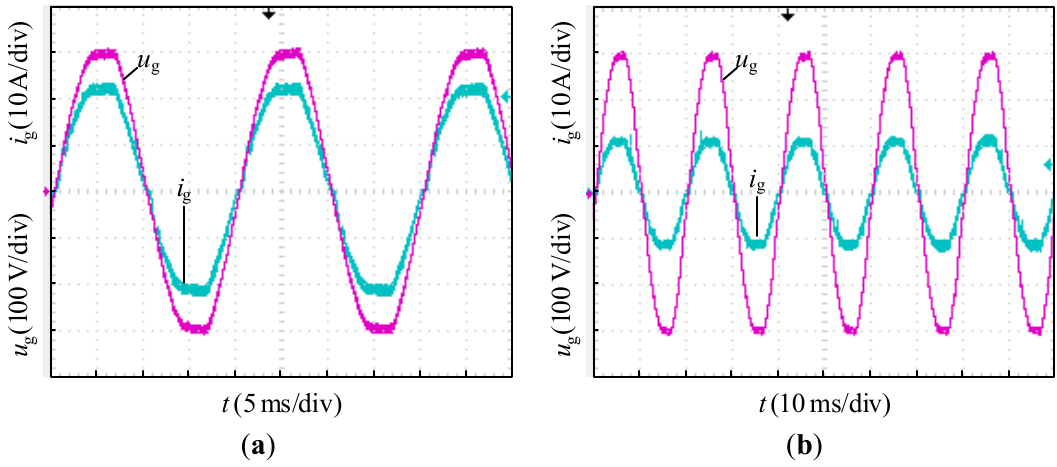
Figure 21. Grid voltage and current in the charging mode: ( a ) u and i at 50% rated power. ( b ) u g g